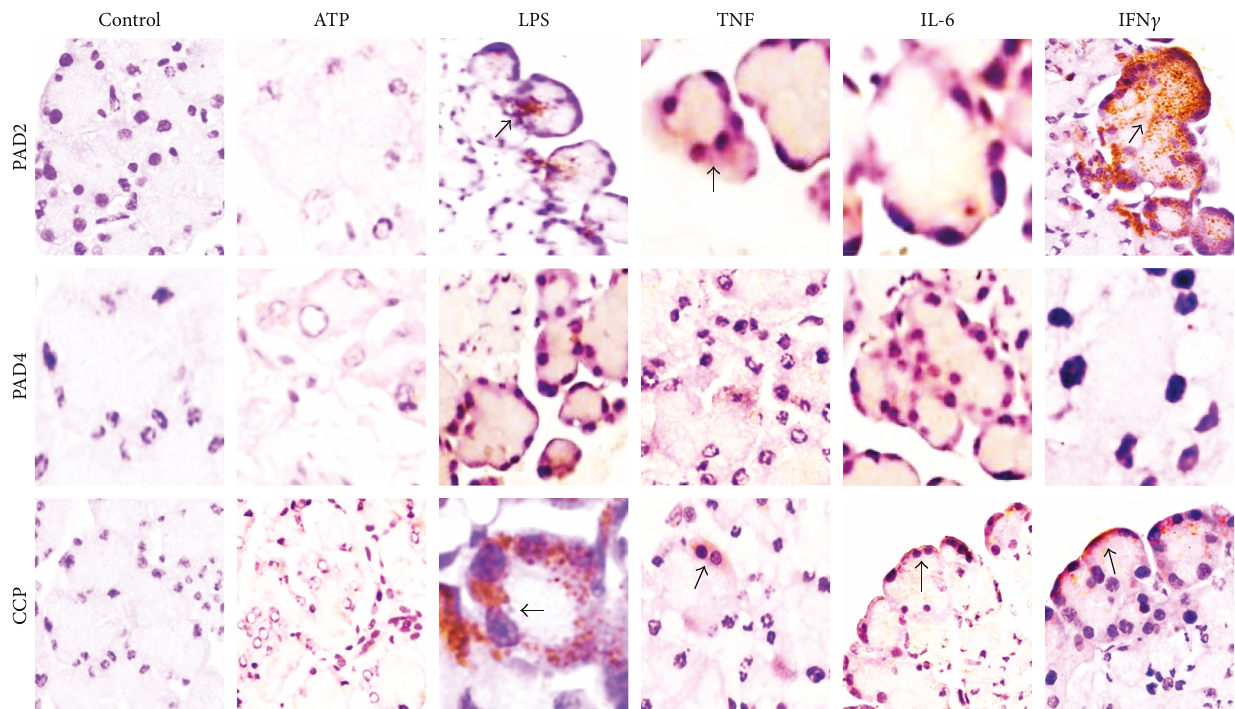
Figure 2: PAD induction by stimulants. PAD2 detection by immunohistochemistry (brown stain). The expression of the enzyme is induced by the stimuli with di ff erent molecular